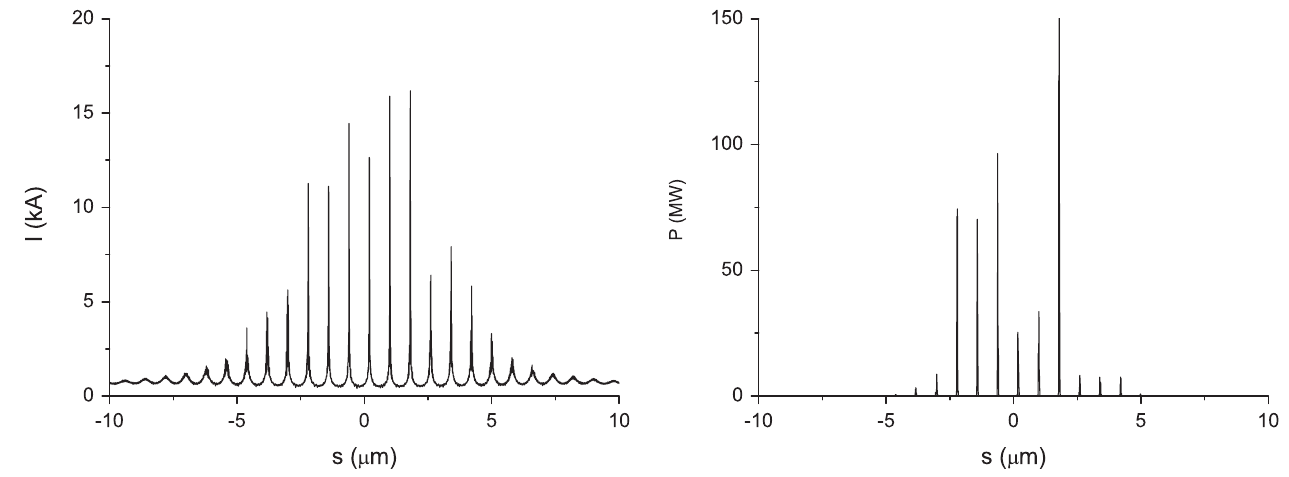
FIG. 13. Modulated electron bunch at the exit of the fourth chicane (left) and power of the radiation from the undulator (right) for the case of a relatively long pulse (35 fs FWHM) from the Ti:Sa laser. The calculations were performed with LOSCA and FAST